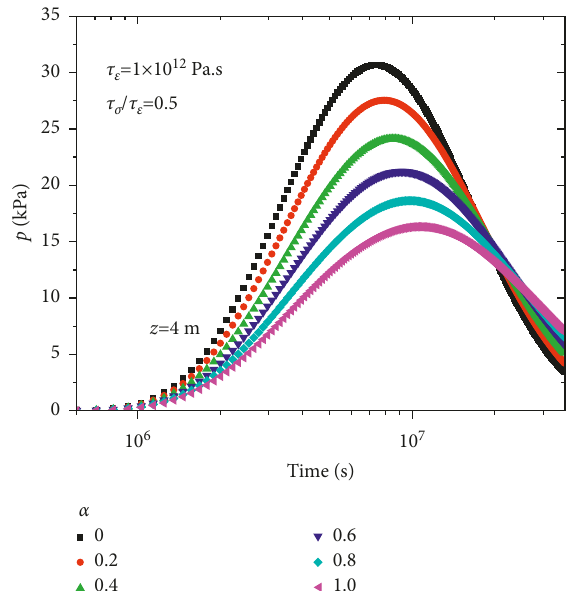
Figure 6: Influence of the order of the fractional derivative on excess pore pressure when τ